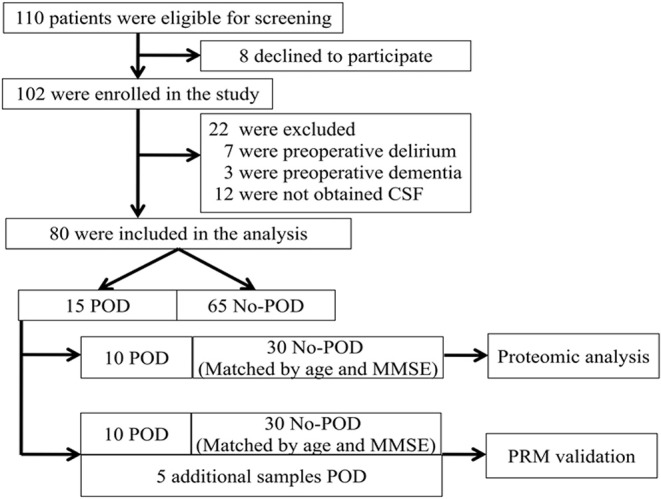
Flow diagram showing the recruiting criterion. One hundred and ten patients were initially screened for the study, and 80 patients were finally included in the data analysis. CSF, cerebrospinal fluid; POD, postoperative delirium; MMSE, mini-mental state examination; PRM, parallel reaction monitoring.